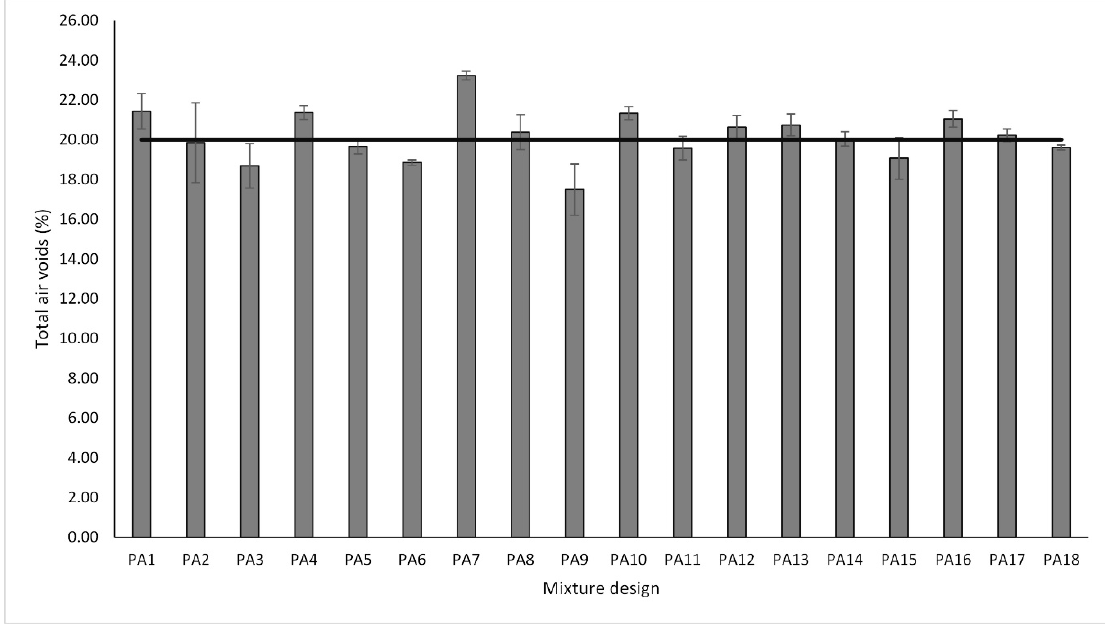
Figure 3. Total air voids response variable. Materials 2020 , 13 , 675